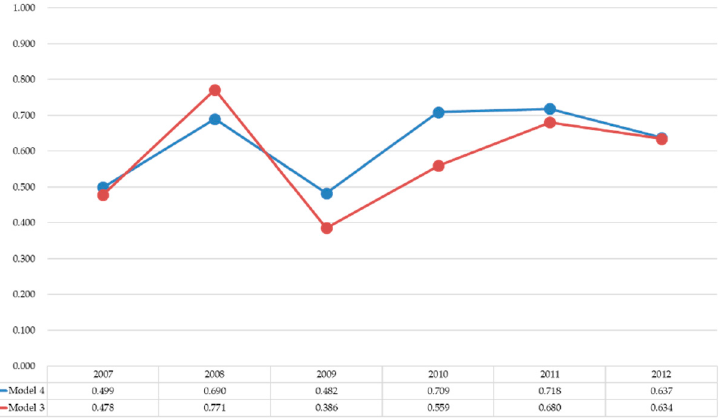
Figure 3. The trend of banking profitability performance with or without NPLs over the sample period.